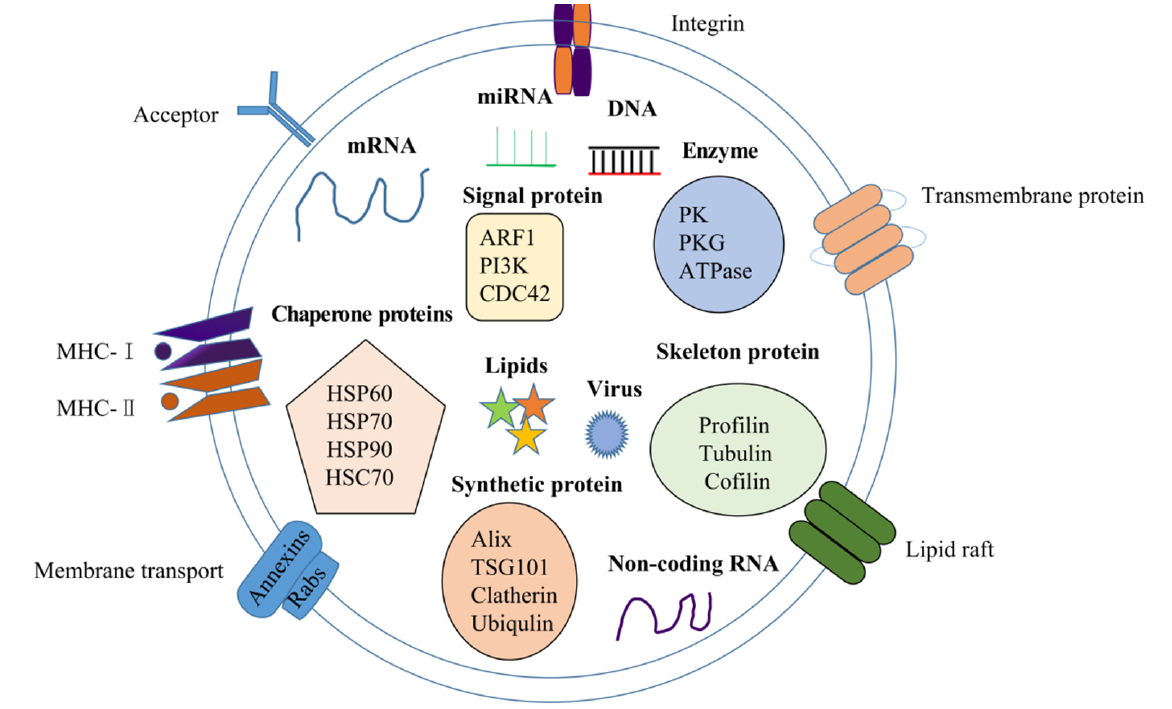
Figure 2. The schematic diagram of exosomal components. Table 1. Clinical significance of molecular markers of tumor-derived